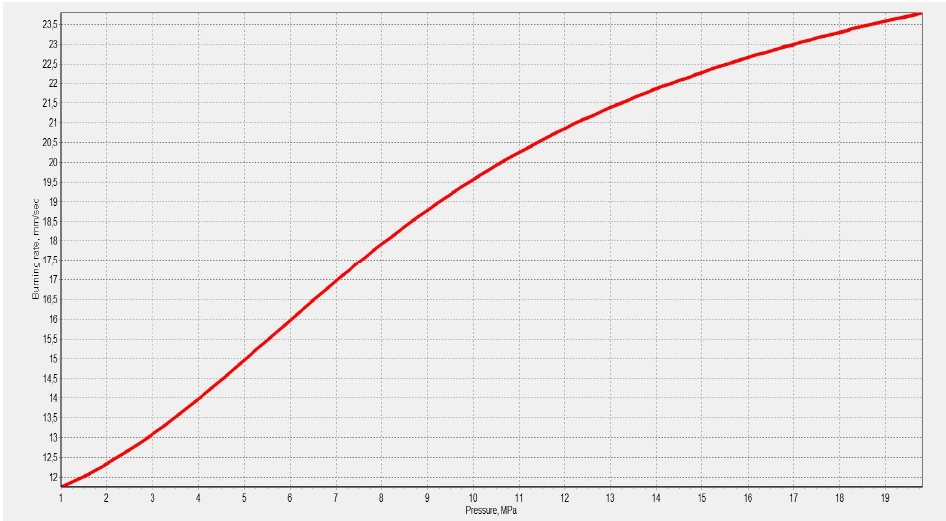
Figure 8. The graphs of the dependence of the burning rate on pressure, corresponding to the results of calculation of ANN MCM for real experiment (left side of the Table 3, direct task for the propellant for which real experiments were carried out).